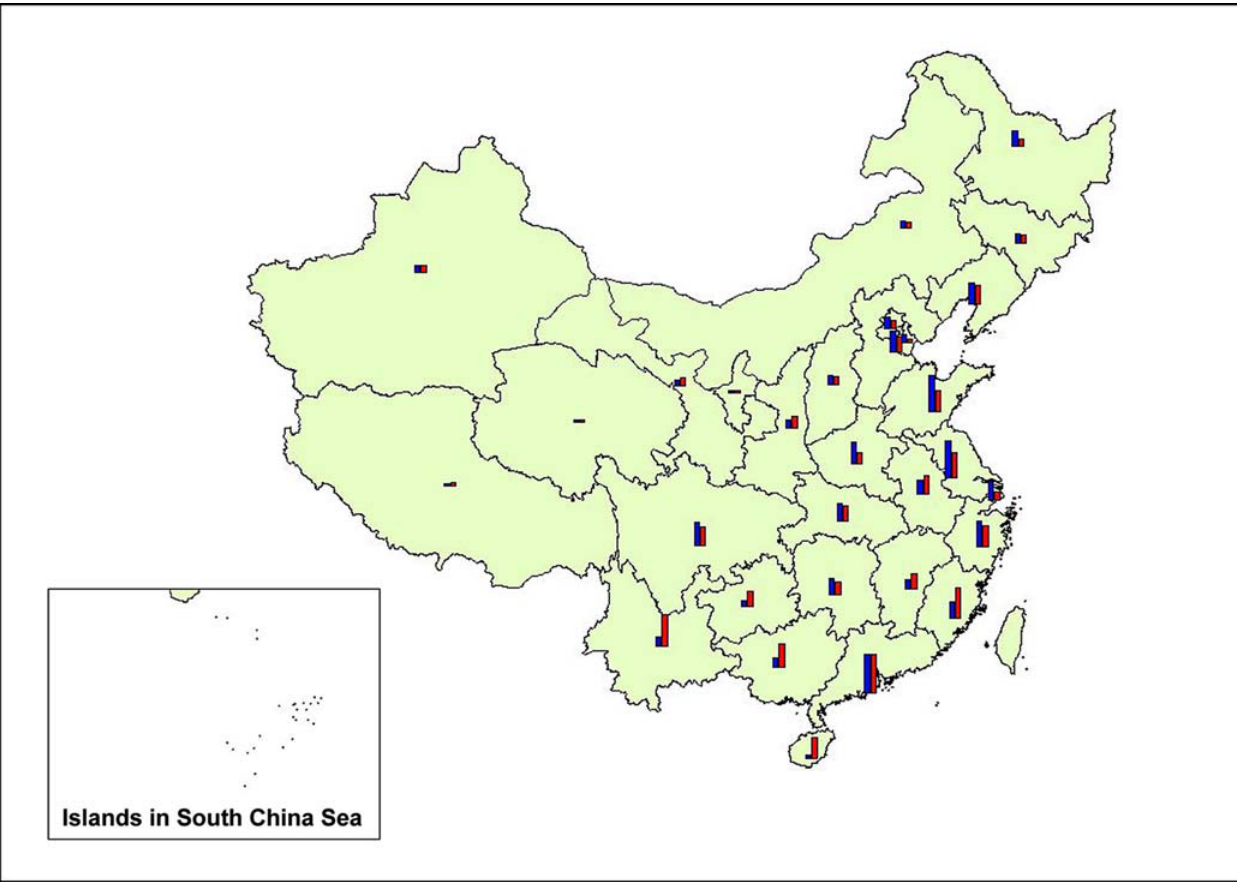
Figure 2. Distribution of the number of invasive species and average GDP in each province in China. The two bars (red bar for the number of invasive species, blue bar for average GDP from 1985 to 2004) are standardized with same height in Guangdong province which has the highest average GDP (76.7 billion USD) and the highest abundance of invasive species (117 species).